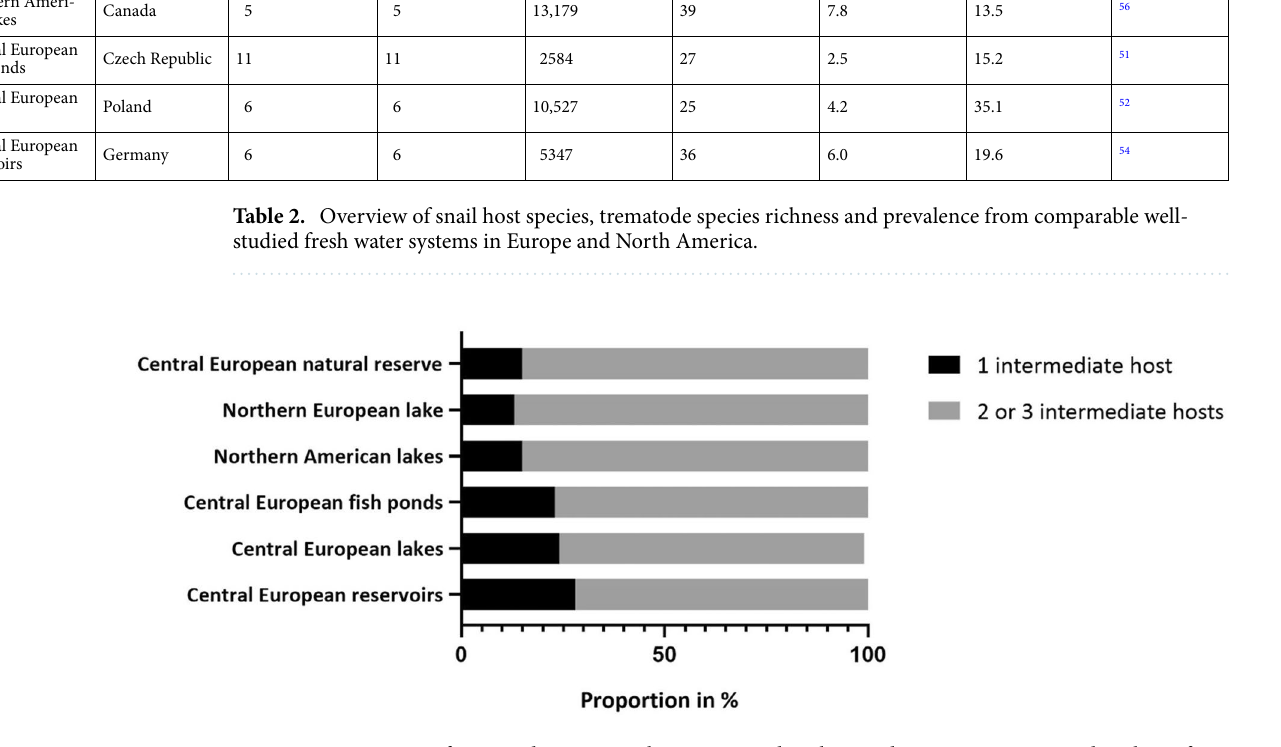
Figure 4. Proportion of trematode species with one intermediate host and two or more intermediate hosts for the studied Central European natural reserve in comparison to five freshwater systems with varying degree of anthropogenic